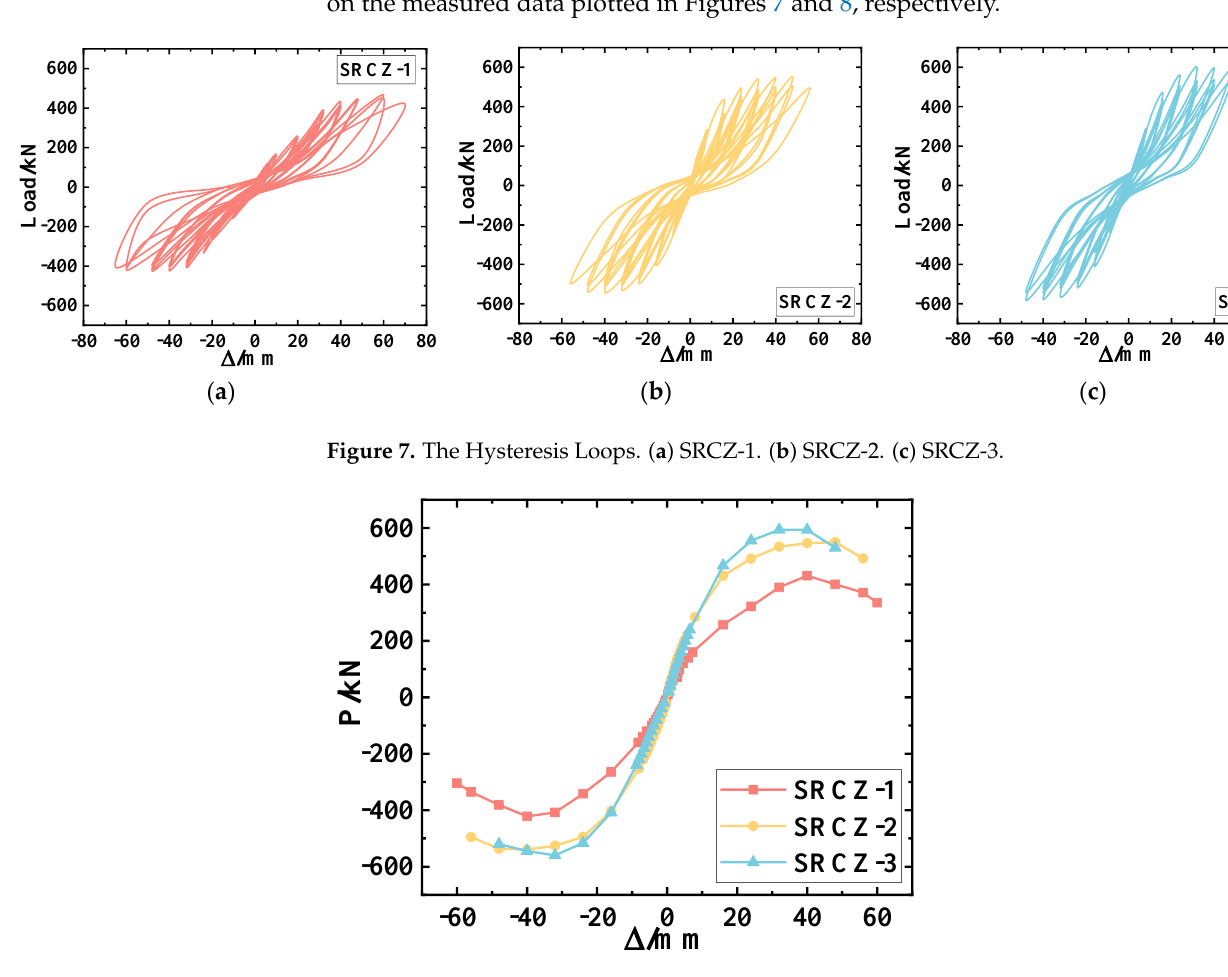
Figure 8. The Skeleton Curves.